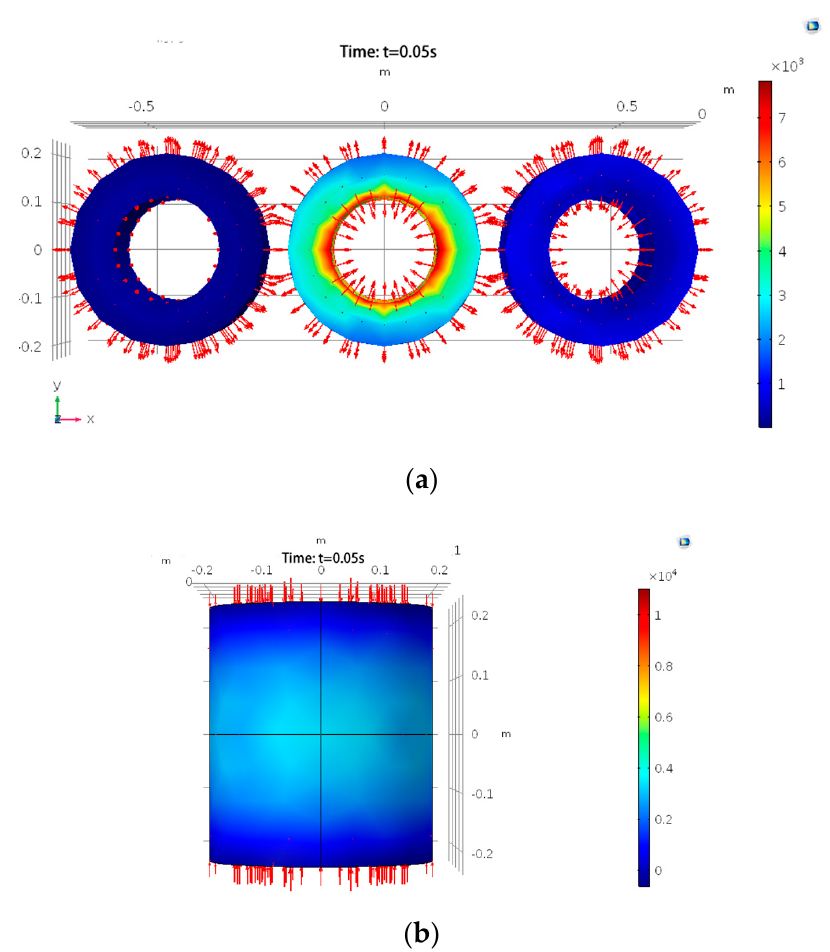
Figure 10. ( a ) Radial-stress distribution diagram of transformer windings; ( b ) axial-stress distribution diagram of transformer winding.